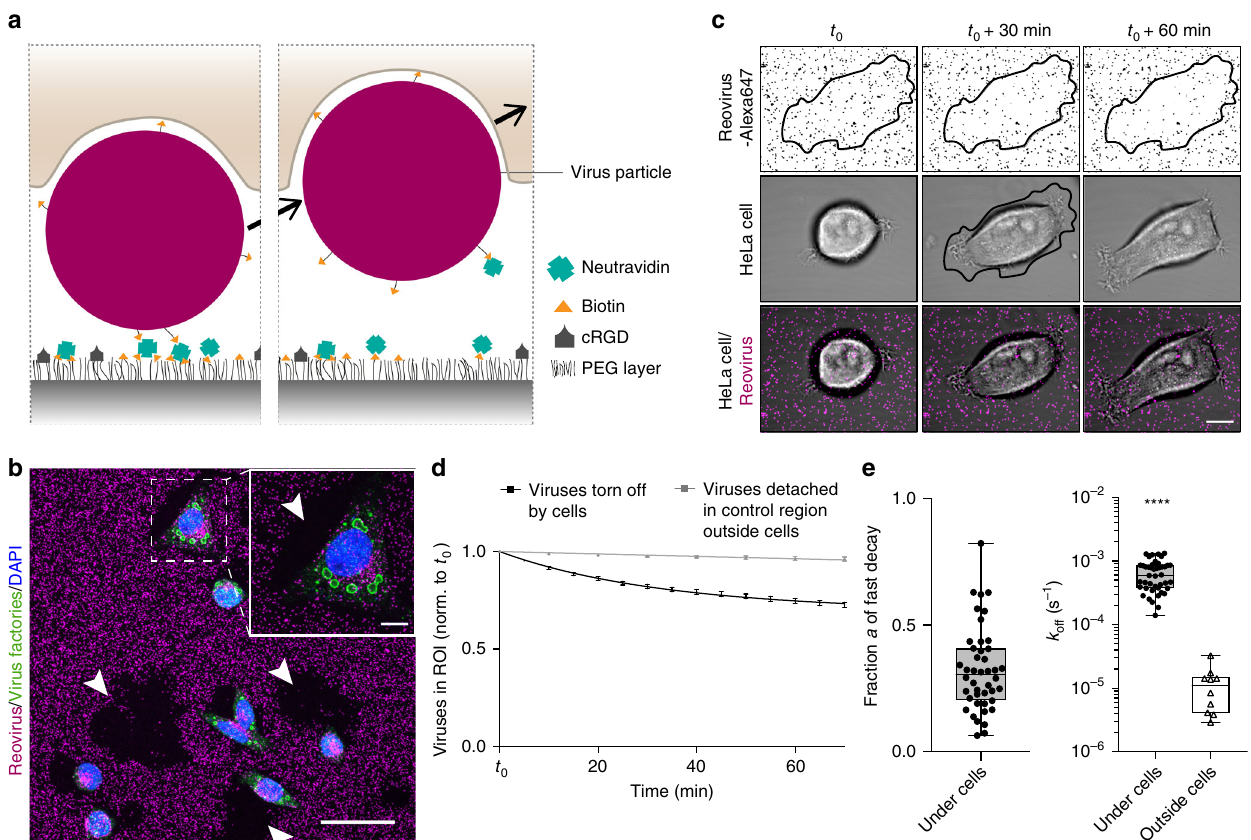
Fig. 2 Forces during virus uptake from the ventral cell side exceed biotin-neutravidin unbinding force. a Schematic of a cell tearing off a biotin- neutravidin surface-bound virus particle. b Immunostaining for viral infection in HeLa cells (green, virus factories) upon tearing off biotin-neutravidin bound reovirus particles (magenta) from the surface. Arrowheads point towards regions where cells removed viruses completely from the surface. Scale bars, 50 and 10 µ m in zoom-in. c Confocal time-lapse images of a HeLa cell (transmission) spreading and tearing off Alexa647-labeled reovirus particles (magenta) from the biotin-neutravidin surface with the cell outline at t 0 + 30 min de fi ning the region of interest (ROI). Scale bar, 10 µ m. d Normalized number of virus particles over time either in the ROI under HeLa cells or in a control region outside cells. Data are represented as mean ± s.e.m. and fi tted with two-phase decay or single exponential decay functions for ROI under cells and outside cells, respectively. e Fitting parameters a , the fraction, and k off , the off rate of particles being actively removed by cells or detaching outside cells. ( n = 44 cells with a total of 5598 viruses and 10 control regions with 6892 total viruses from seven technical replicates. Box-plots represent median± 95% CI with whiskers to the min and max values, **** P < 0.0001 according to unpaired two- tailed Mann – Whitney test). Source data are provided as a source data fi